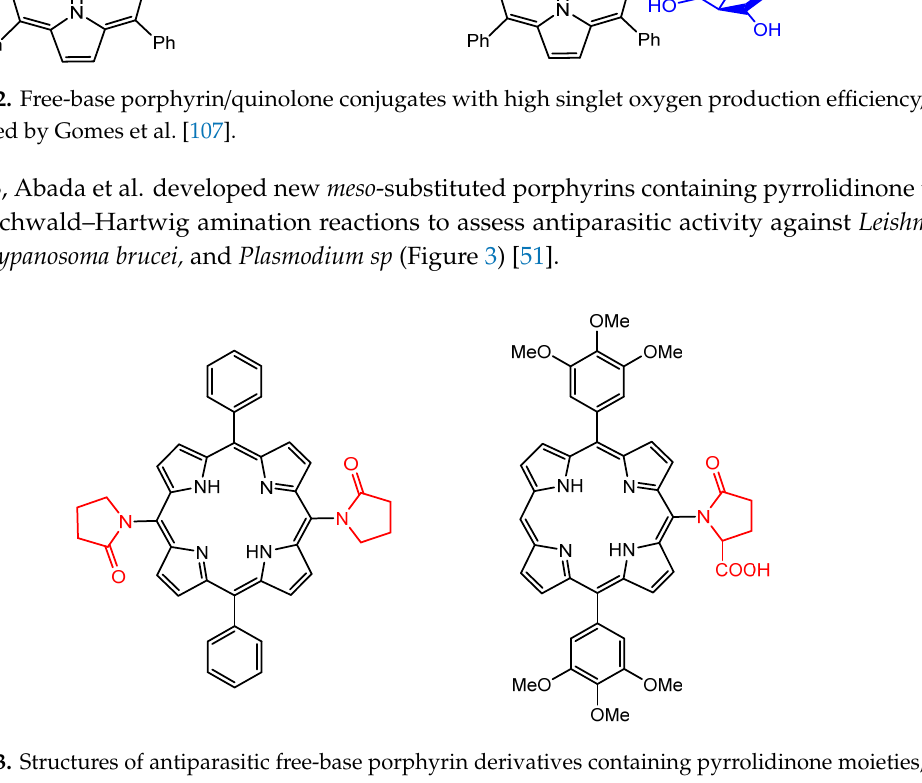
Figure 4. Structures of the amino-triazole and amino-thiadiazole free-base porphyrins with enhanced antiparasitic activity, prepared by Bastos et al. [108].